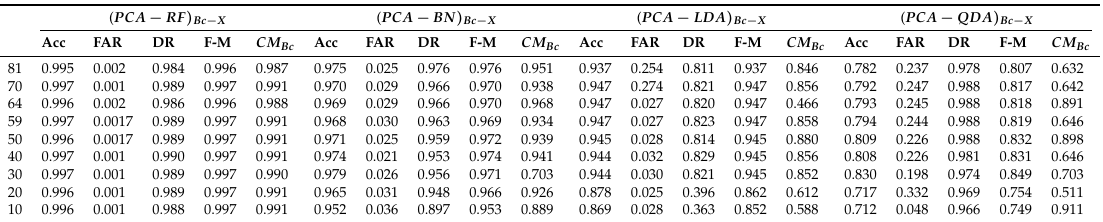
Figure 4. Binary Class Classification: Detection Rate in terms of number of features using Auto-Encoder. Table 8. Performance evaluation of the proposed framework in binary classification using